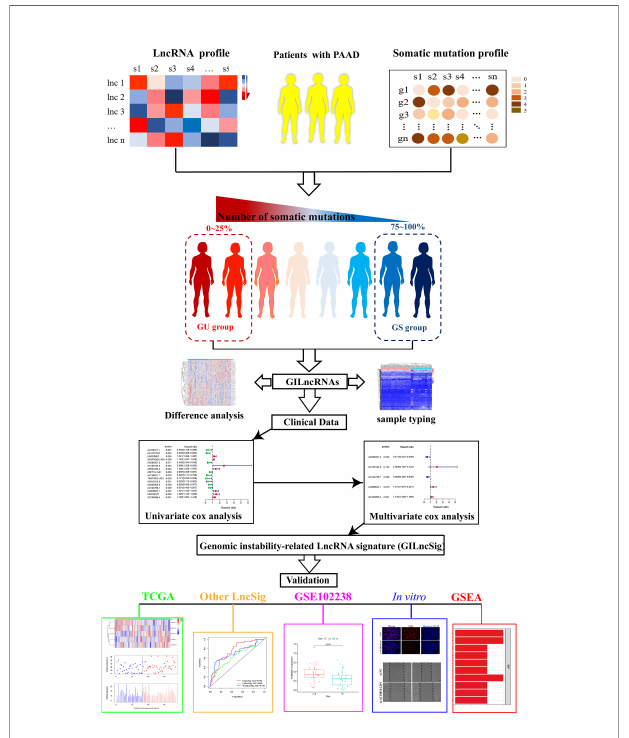
FIGURE 1 | Flow chart of research design used in this